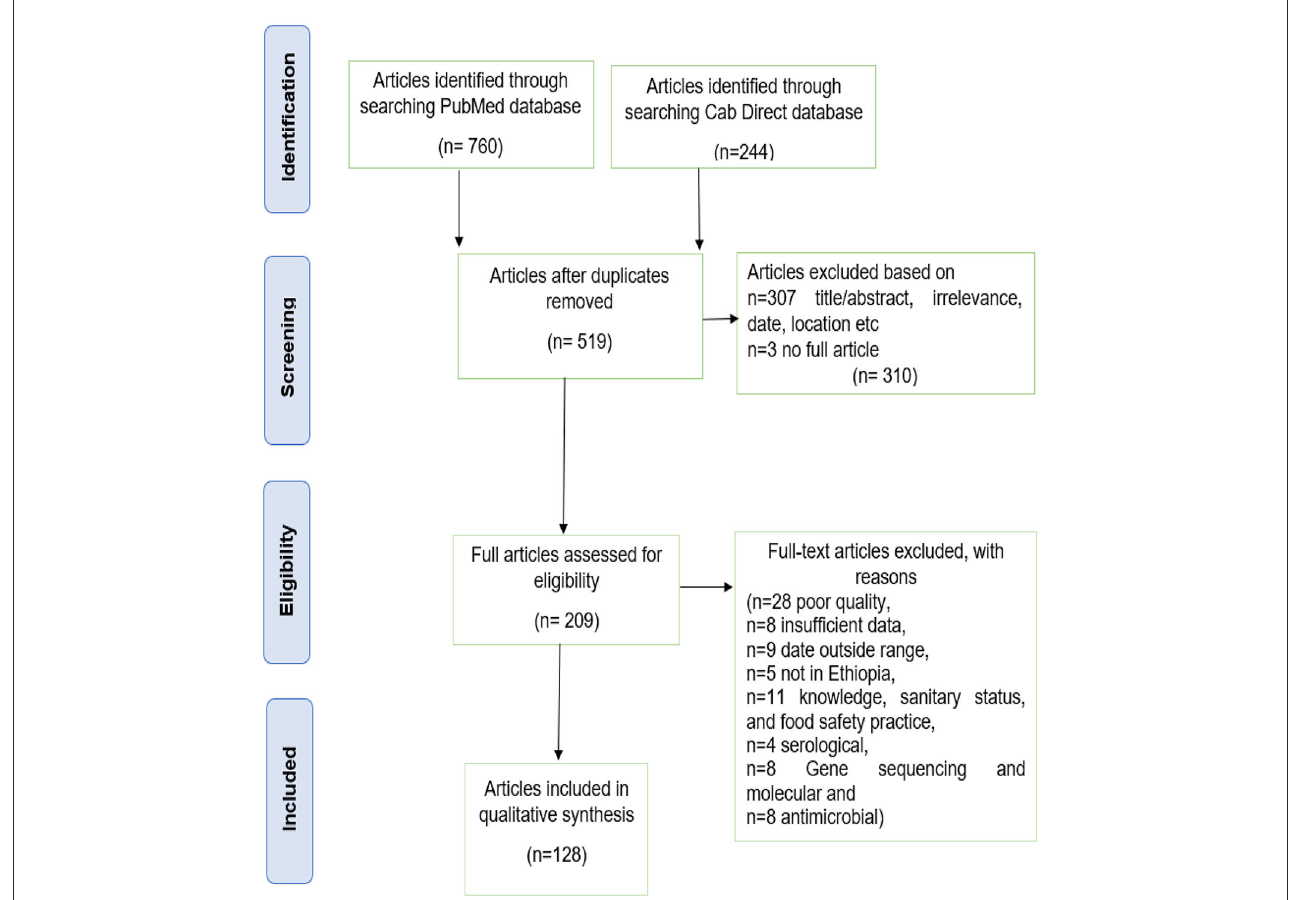
FIGURE1 Flow chart of the process followed during the literature search for data extraction. The PRISMA flow diagram for the systematic review detailing the database searches, the number of abstracts screened, and the full texts retrieved.